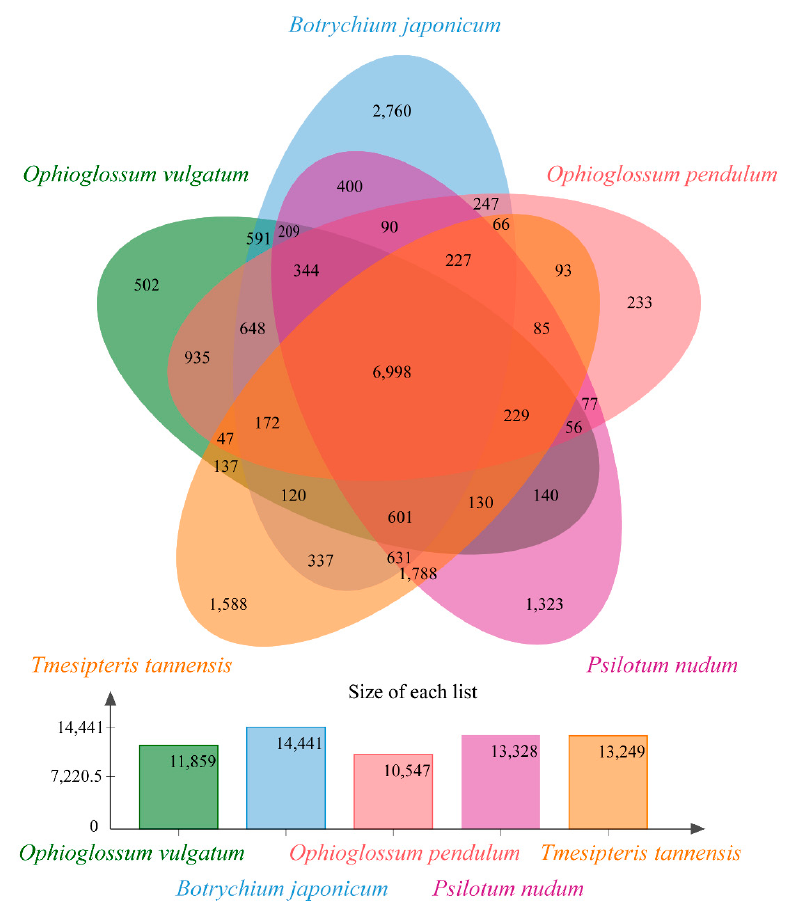
Figure 2. Venn diagram showing unique and shared gene families among members of whisk ferns ( Psilotum nudum and Tmesipteris tannensis ) and ophioglossoid ferns ( Ophioglossum vulgatum , O. pendulum and Botrychium japonicum ). The number in each region represents the number of gene families belonging to that category.